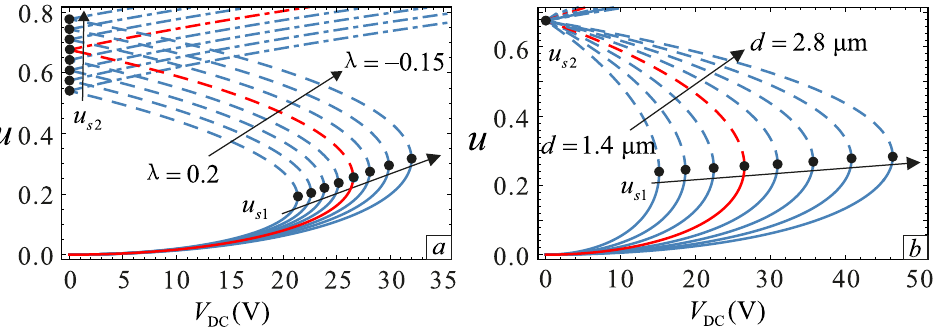
Figure 3. Relationship between the DC voltage and static equilibrium point under different physical parameters. ( a ) The influence of section parameters with d = 2.0 µ m; ( b ) the influence of gap distance with λ = 0. The solid lines represent the stable solution. The dashed lines represent the unstable solution. The dotted lines are also stable, but it is impossible for them to appear in the physical model.